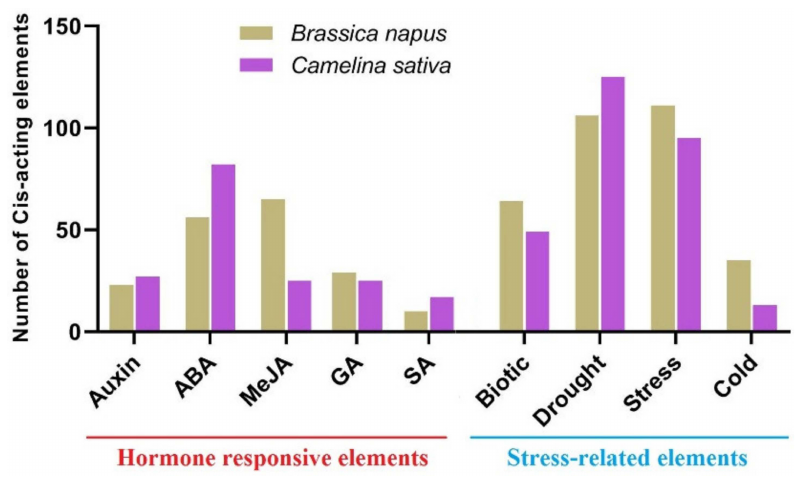
Figure 10. A comparison between the SULTRs from C. sativa and B. napus based on the number of cis-regulatory elements related to hormone and stress responses in promoter sites. More details are provided in Figures S3 and S4.